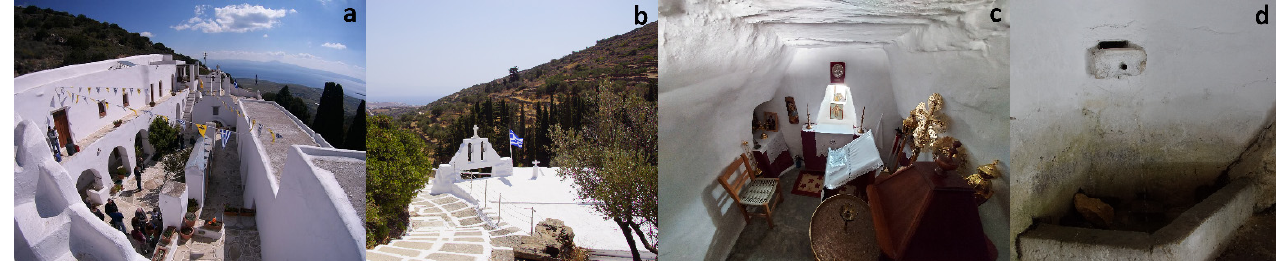
Figure 16. ( a ). Monastery of Agios Georgios; ( b ). Exterior of cave-church of the Transfiguration/Agios Arsenios; ( c ). Interior of cave-church; ( d ). Spring of Afklaki (photos by the author).